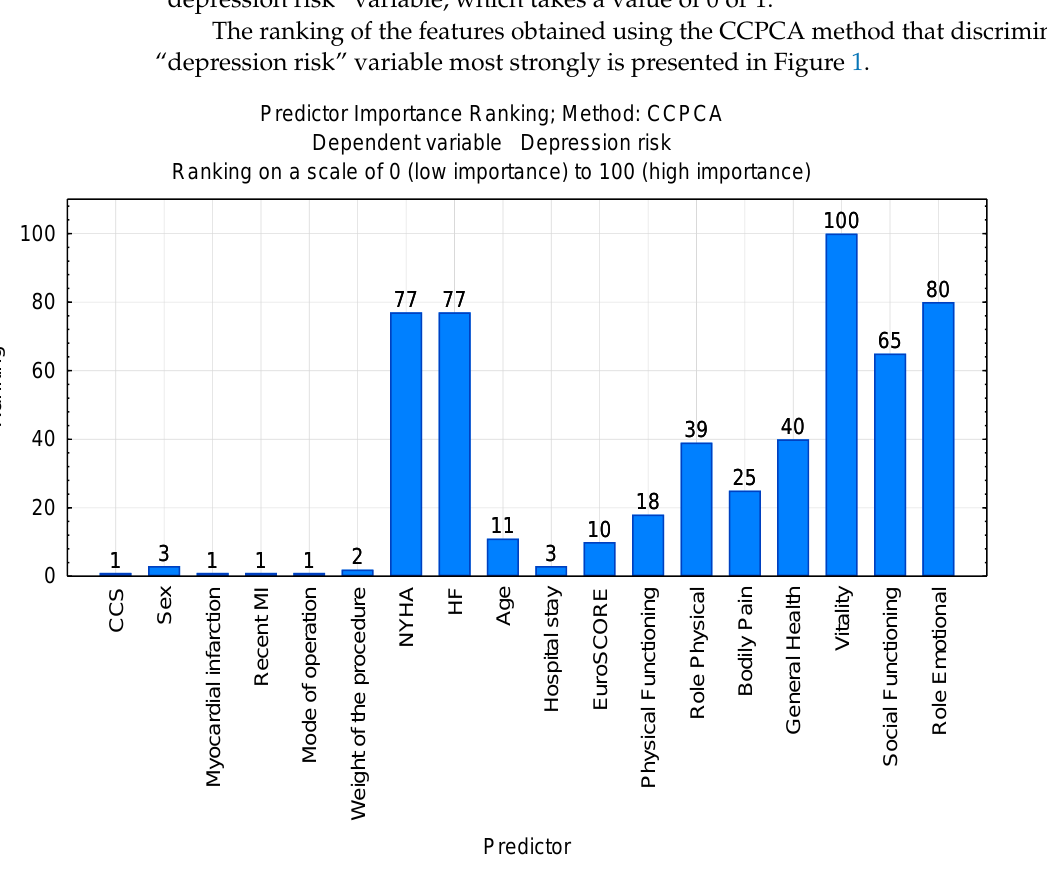
Table 4. Statistics of the correctness of the depression risk classification.